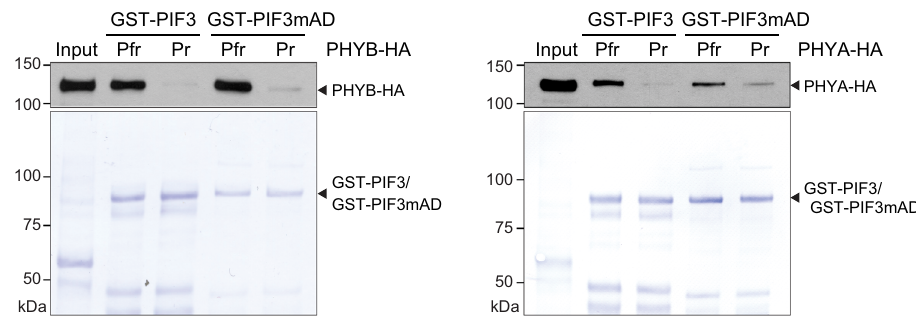
Fig. 3 PIF3mAD retains light-dependent interactions with PHYA and PHYB. GST pulldown results showing that PIF3mAD, like PIF3, interacts preferentially with active PHYA and PHYB. GST pulldown assays were performed using recombinant GST-PIF3, GST-PIF3mAD, or GST to pull down in vitro translated HA-tagged PHYA (PHYA-HA) or PHYB (PHYB-HA) conjugated with a phycocyanobilin chromophore. The pulldown assays were performed in either R or FR light to maintain PHYA-HA and PHYB-HA in the Pfr or Pr conformer, respectively. Input and bound PHYA-HA and PHYB-HA fractions were detected via immunoblots (upper panels) using anti-HA antibodies. Immobilized GST, GST-PIF3, and GST-PIF3mAD are shown in the Coomassie Brilliant Blue-stained SDS-PAGE gels (lower panels). The source data underlying the immunoblots and Coomassie Brilliant Blue-stained SDS-PAGE gels are provided in the Source data fi